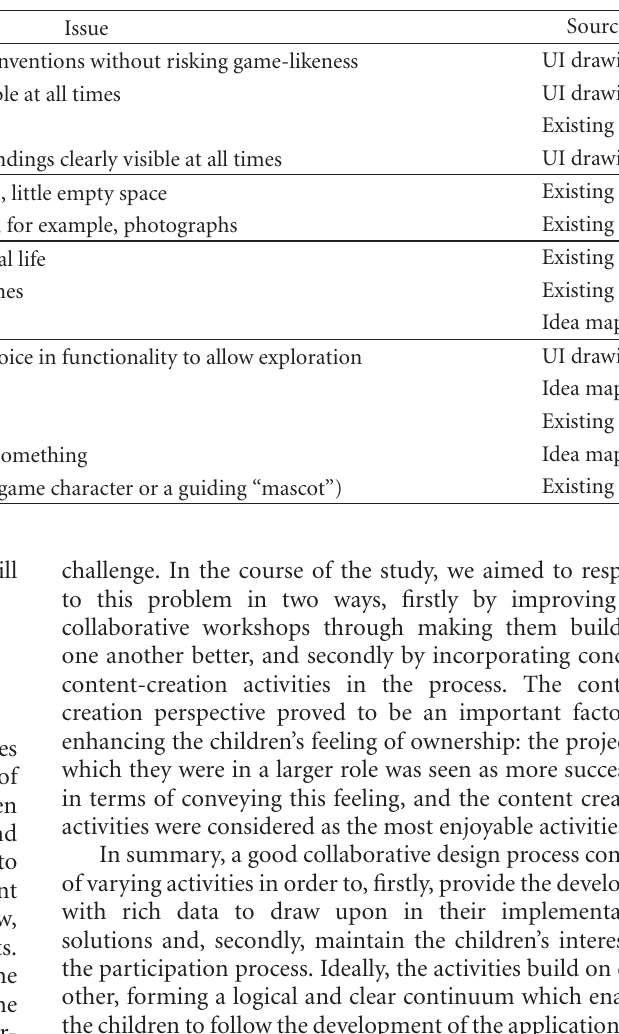
Table 1: Issues discovered in the